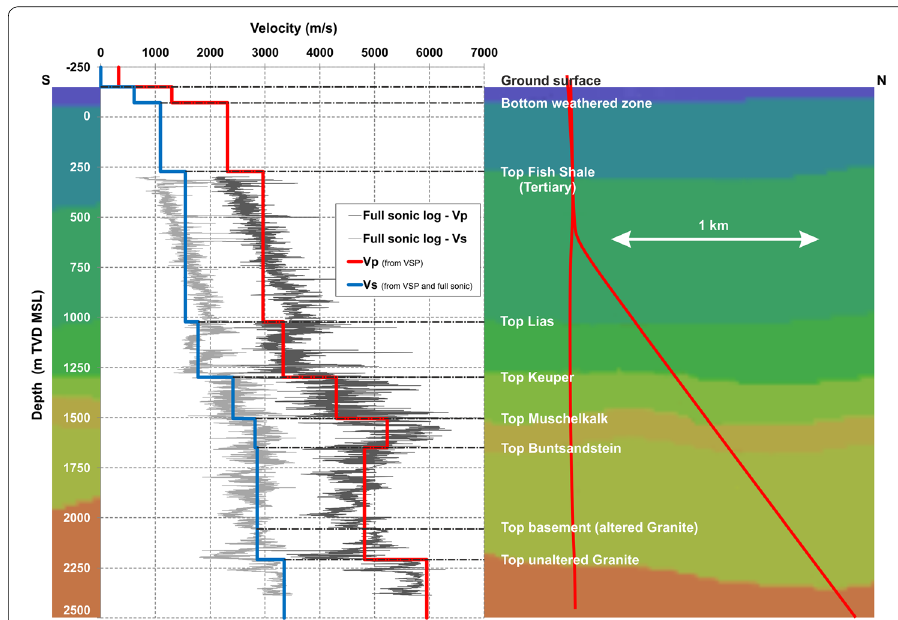
Fig. 4 Vertical profile of the 3D velocity model along GRT-1 overlaying a vertical South–North section of the 3D P-wave velocity model next to GRT-1 and GRT-2 wells (red curves). The red velocity profile indicates the Vp derived from the VSP, the blue velocity profile indicates the Vs derived from the VSP and the Vp/Vs ratio of the full sonic (see text for further explanations). The Vp and Vs measured by the full sonic log are presented for comparison in dark and light gray,